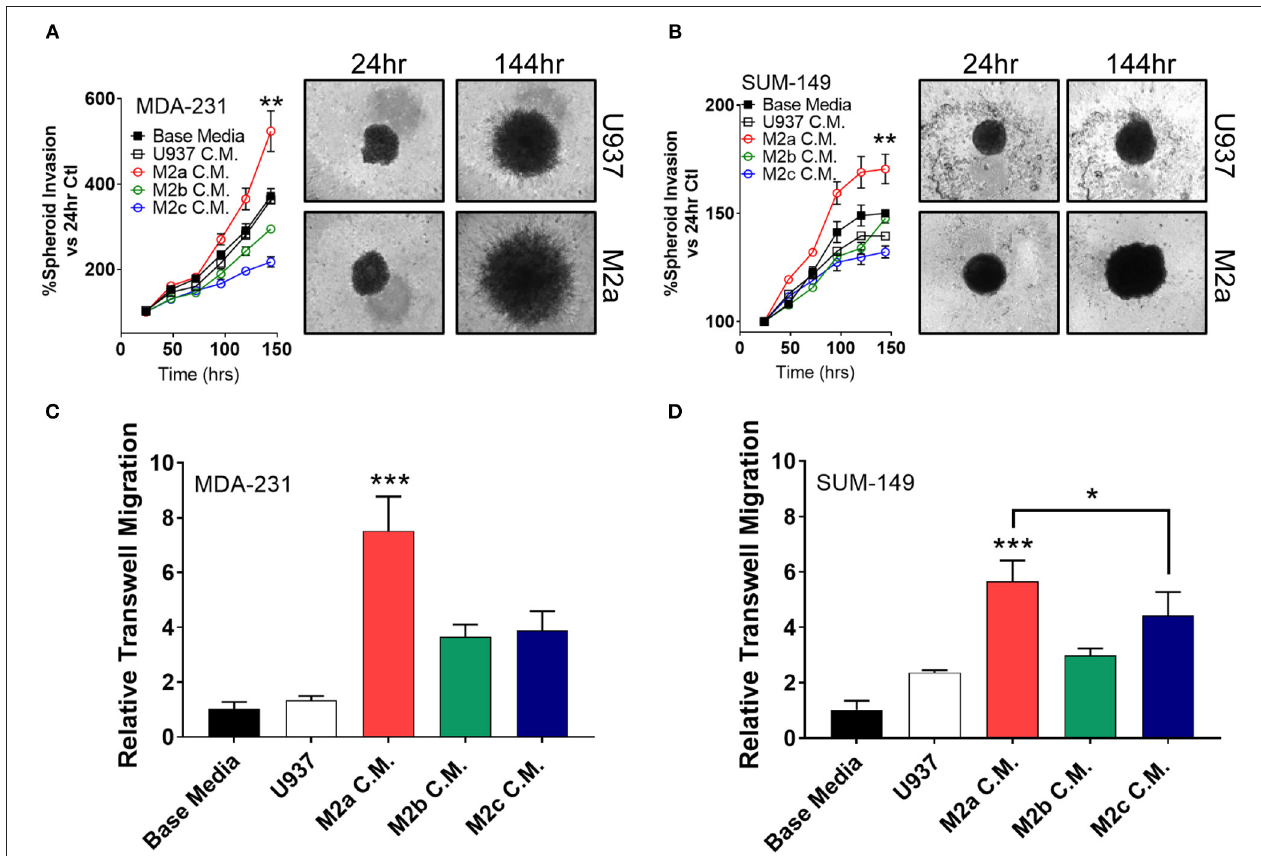
FIGURE 2 | 3D cell invasion assays confirm M2a TAMs as the greatest enhancer of breast cancer cell invasion. (A) Results from spheroid invasion assays in MDA-231 cells display a strong response to M2a conditioned media (C.M.). (B) Spheroid invasion results from the inflammatory TNBC cell line, SUM-149. Statistical significance in (A,B) is displayed as the 144h time point compared against all other 144h time points. (C,D) Results from 3D transwell migration confirm M2a conditioned media (red) enhances MDA-MB-231 (C) and SUM-149 (D) cancer cell invasion. All results are compiled from ≥ 2 independent experiments; Statistical significance was determined by one-way ANOVA; error bars represent ± standard deviation; p -value is displayed as * p < 0.05, ** p < 0.01, *** p <